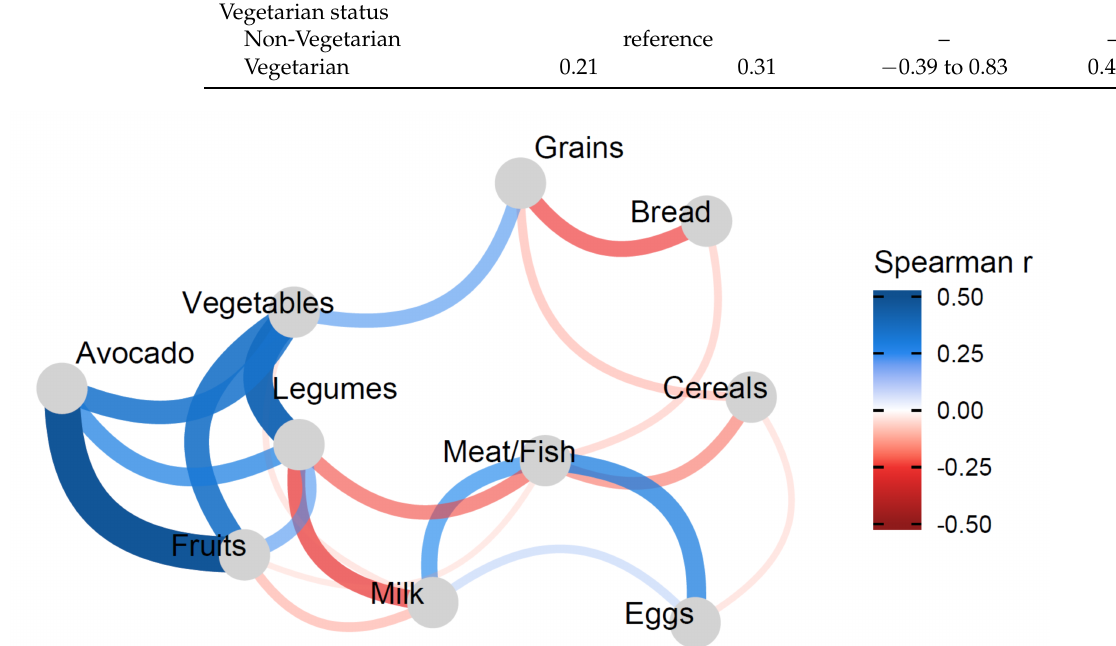
Figure 2. Correlation network showing the associations between avocado intake and intake of other foods. Blue represents positive while red represents inverse correlations. For examples, avocado intake is highly positively correlated with intake of fruits and moderately positively correlated with intake of vegetables and legumes, whereas legumes is strongly positively correlated with vegetables and positively moderately correlated with fruits, but moderately negatively correlated with intakes of milk and meat/fish; grains intake is weakly positively correlated with intake of vegetables but moderately negatively correlated with intake of bread and weakly negatively correlated with cereal intake, and so